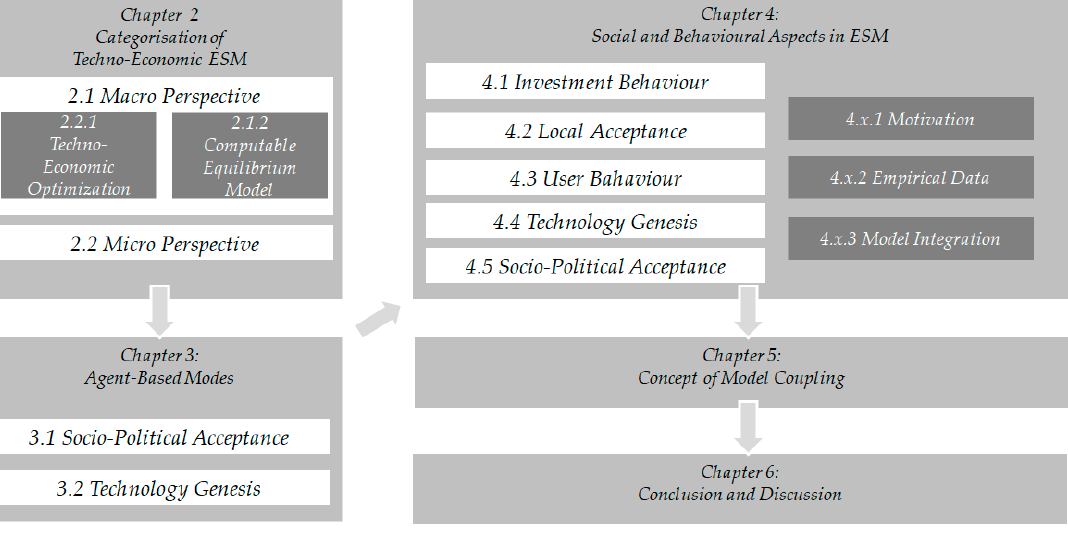
Figure 1. Overview of the article structure.